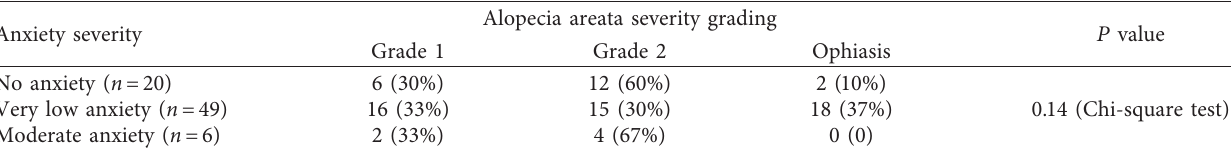
Table 4: Relation between anxiety and alopecia areata severity